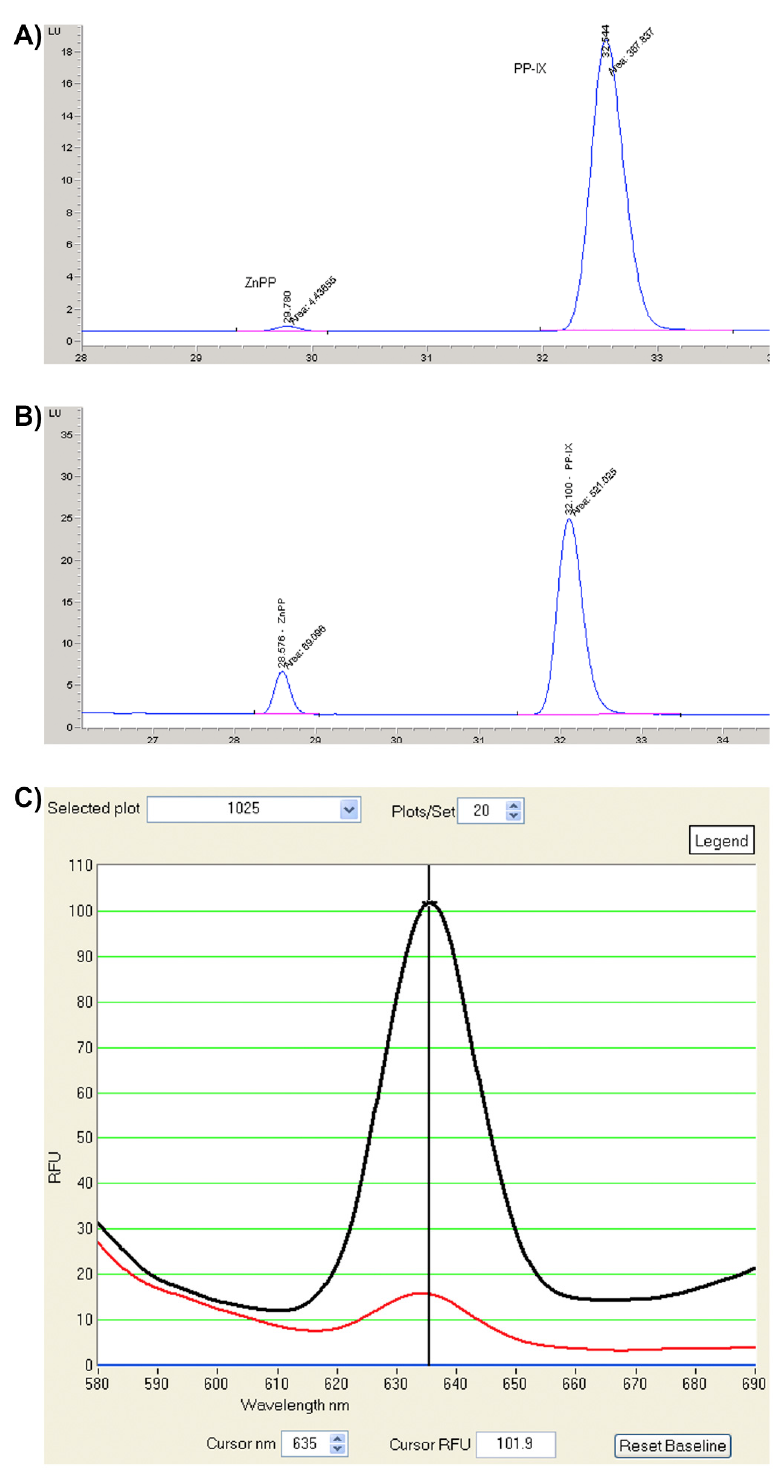
Figure 1. Protoporphyrin detection. ( A ) Chromatographic profile of erythrocyte porphyrins from an EPP patient. ( B ) Chromatographic profile of erythrocyte porphyrins from an XLP patient. ( C ) Plasma fluorimetric emission scanning at high (black line ) and low (red line) concentrations. PPIX: metal-free protoporphyrin IX and ZnPP: zinc protoporphyrin.